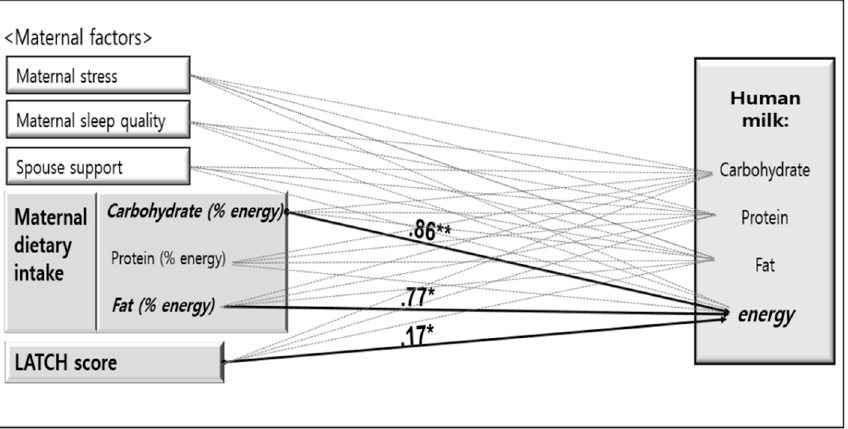
Figure 1. Graphical description of the human milk influencing factors. The dotted lines indicate a statistically insignificant association, whereas the solid lines indicate a statistically significant association. Values above the solid lines indicate the correlation coefficients drawn from the regression.